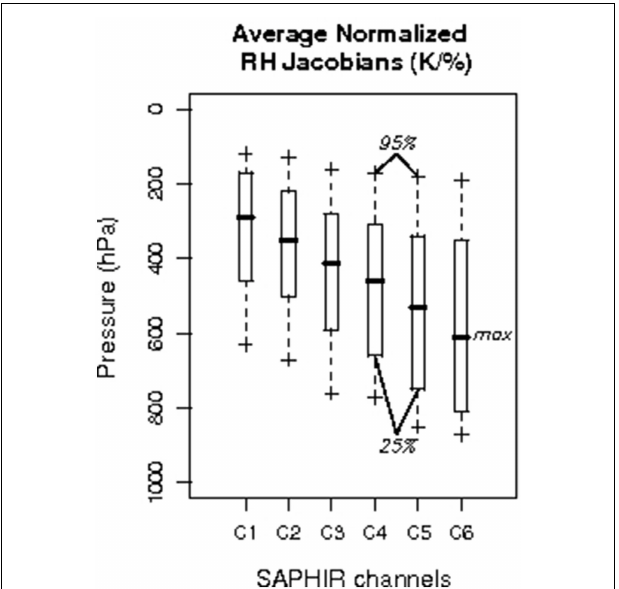
FIGURE 4 | Relative humidity jacobians ∂ TB/ ∂ RH, in K/% of the 6 channels of SAPHIR for a tropical relative humidity profile observed at nadir by the RTTOV model. The whiskers indicate the lower and upper limits of the distribution.